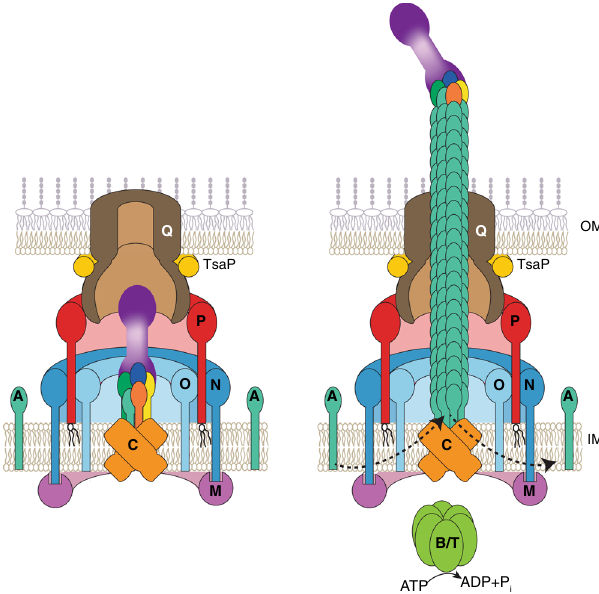
Fig. 6 Three functions of the PilY1/minor pilin complex. Left panel, architectural model of non-piliated T4aPM with ten core proteins and the priming complex composed of PilY1, four minor pilins, and one PilA subunit. Right panel, architectural model of piliated T4aPM with ten core proteins and the priming complex at the pilus tip; in the piliated T4aPM, PilB and PilT associate with PilC in a mutually exclusive manner during extension and retraction, respectively. For simplicity, PilB and PilT are not shown separately. Proteins labeled with single letters have the Pil pre fi x. Color code for PilY1 and minor pilins as in Fig.